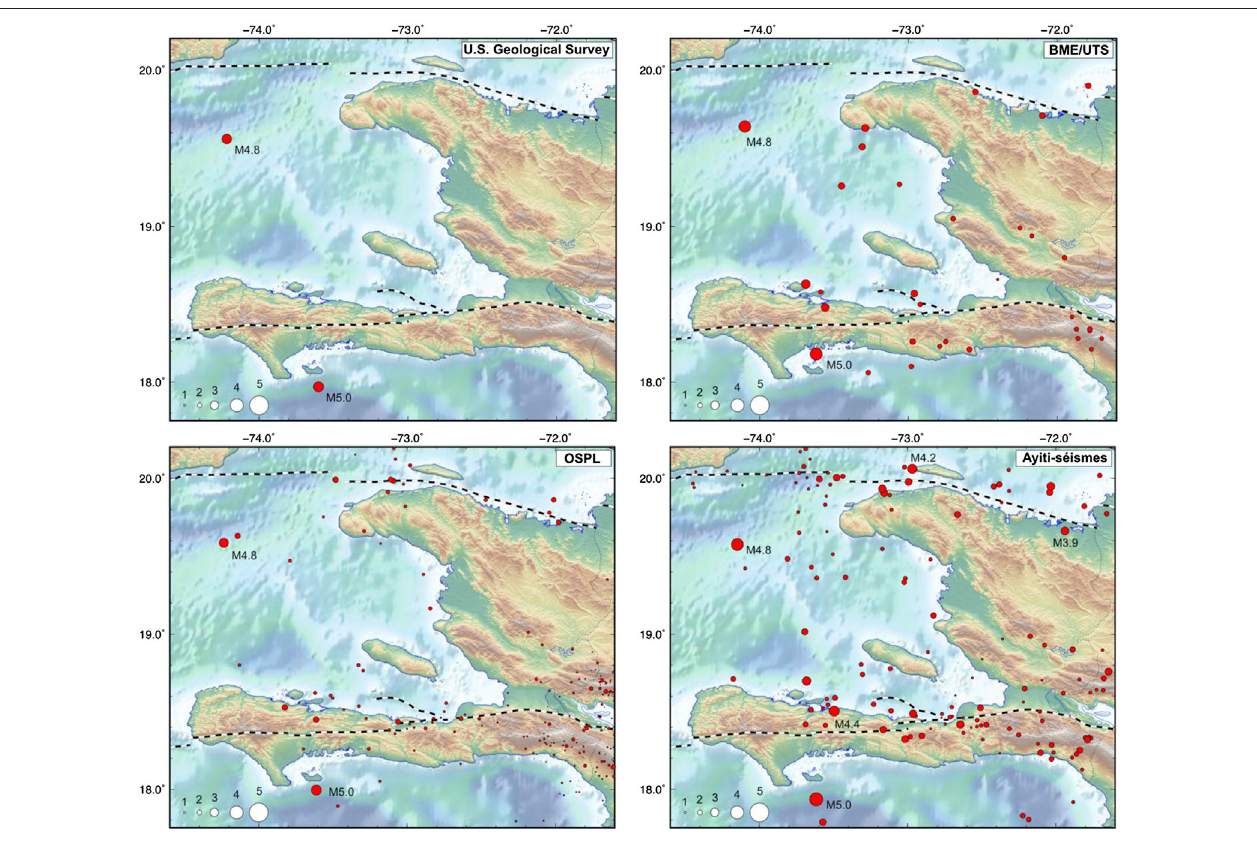
FIGURE 3 | Comparisons of earthquake locations for the August 1, 2019 to December 31, 2019 time interval. Top right: the U.S. Geological Survey uses a global distribution of seismic stations and, for the Haiti region, reports events with magnitude greater than 4 – 4.5. Top left: the Haiti Bureau of Mines and Energy uses its broadbandstations( Figure1 )andseveralotherregionalstations.Duringthetimeintervalconsideredhere,theiroperationswereseverelyaffectedbythepoliticalcrisisin Haiti, whichlimited thenumber ofeventsthey could detect. Bottom-left: theLoyola PolytechnicSeismological Observatory (OSPL)in theDominicanRepublic uses theirownstationsinthesouthernpartoftheircountry,whichexplainsthelargernumberofdetectionsinthesouth-easterncornerofthemap.Bottomright:Ayiti-séismes uses Raspberry Shake and broadband stations in Haiti, as well as 20 other regional stations. Its magnitudes may be slightly overestimated, as discussed in the text.